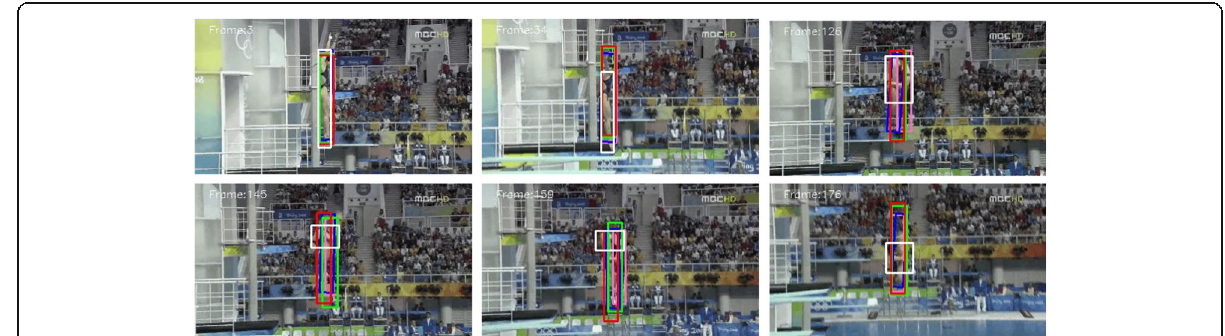
Fig. 19 The tracking results for the video “ Diving ” using CAM-Shift (white), PF (blue), VAPF (green), M-PF (pink), and the proposed tracker (red). Particle number N = 200